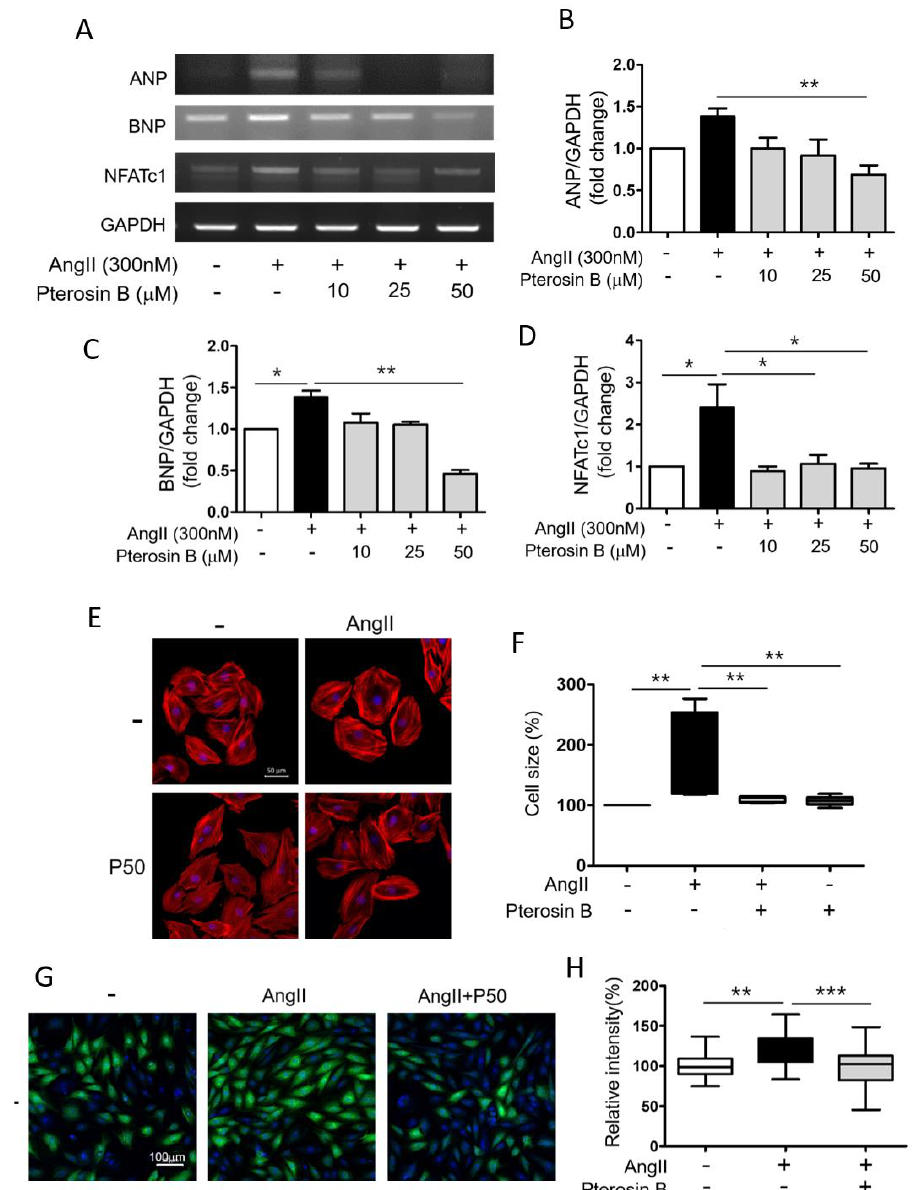
Figure 2. Anti-hypertrophic E ff ect of Pterosin B on Ang II-stimulated H9c2 cells. H9c2 cells were treated with 10–50 µ M Pterosin B for 48 h in the presence of 300 nM ANG II. ( A ) Expression levels of cardiomyocyte hypertrophy-related mRNAs (ANP, BNP, and NFATc1) were estimated by reverse transcriptase PCR. ( B – D ) The ANP, BNP, and NFATc1 mRNA expression levels were normalized by GAPDH. * p < 0.05, ** p < 0.01. n = 3. ( E ) Texas-Red X-tagged phalloidin was stained for F-actin in H9c2 cells. Representative image was detected by confocal microscopy. P50 = Pterosin B (50 µ M). Scale bar = 50 µ m. ( F ) Average cell size was measured in each group and analyzed by Image J software. ** p < 0.01. n = 6. ( G ) Protein synthesis of H9c2 cells was determined using Click-iT ® HPG Alexa Fluor ® 488 Protein Synthesis Assay Kit. Green fluorescence indicates synthesis of new intracellular proteins and blue fluorescence (DAPI) indicates nucleus. P50 = Pterosin B (50 µ M). Scale bar = 100 µ m. ( H ) Quantification of the fluorescence intensity of protein synthesis. ** p < 0.01, *** p < 0.001. Scale bar = 100 µ m. n = 4.